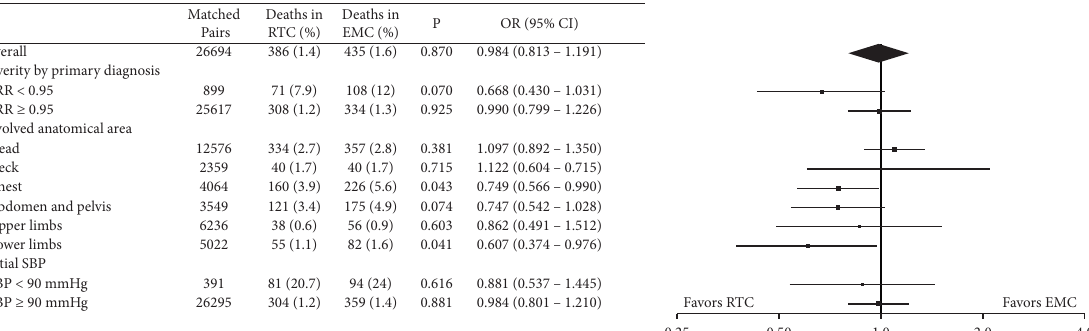
Figure 3: A Forest plot comparing the in-hospital mortality of matched cases treated in the regional trauma centers (RTC) and the emergency centers. An odds ratio below 1.0 indicates a more favorable result in the RTC. RTC: regional trauma center; EMC: emergency medical center; OR: odds ratio; SRR: survival risk